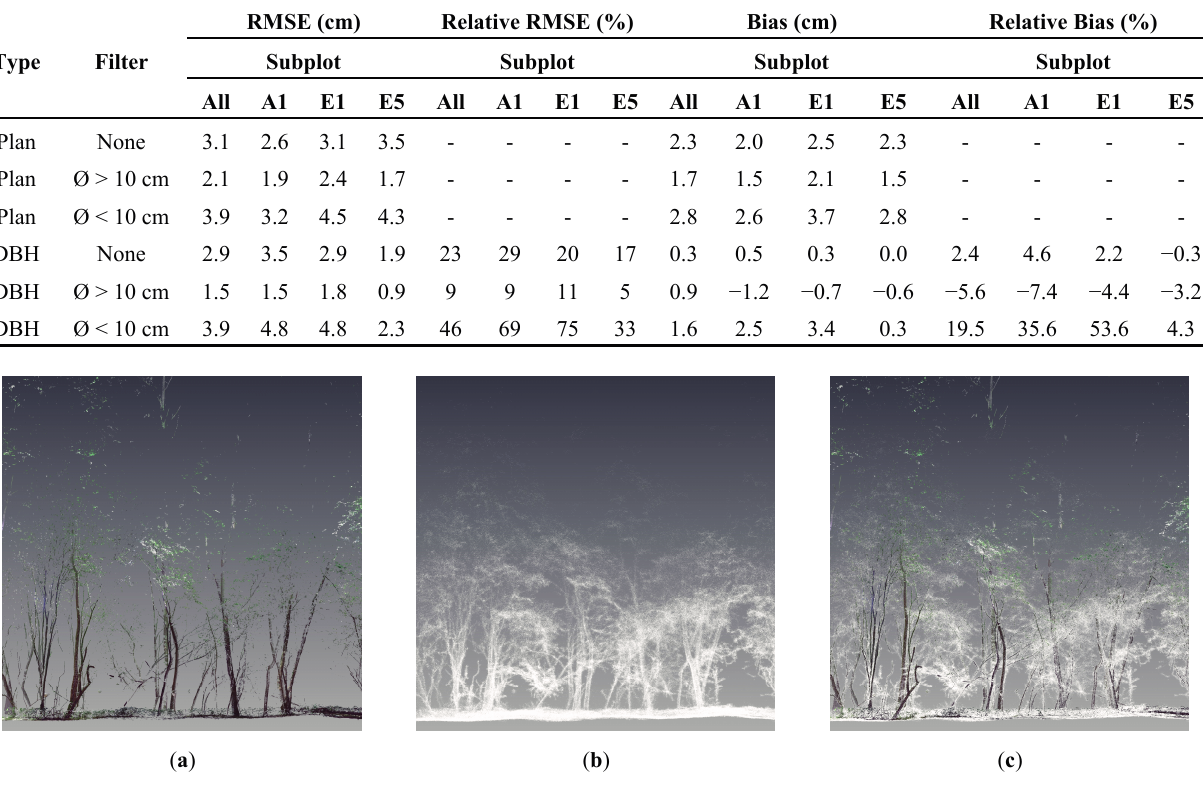
Figure 5. Point cloud comparisons for ( a ) FARO ( b ) ZEB1 and ( c ) combined data sets.